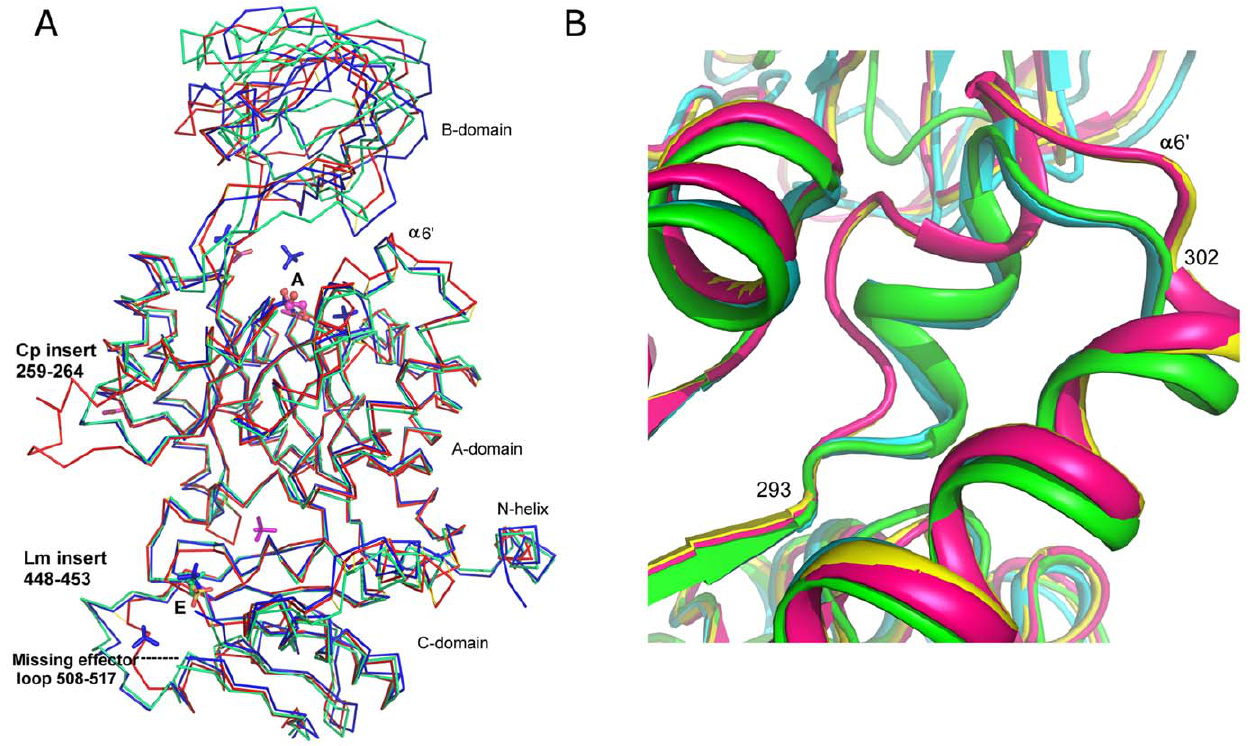
Figure 4. Comparison of CpPyK with LmPyK. (A) Superposition of A monomers of CpPyK (red), L. mexicana PyK without sulfate ion in the active site (1PKL, green), and L. mexicana PyK with sulfate ion in the active site (3E0V, blue). Sulfate ions bound at the effector binding site (labeled E) in all three structures are shown as stick models: CpPyK (yellow and red), 1PKL (green) and 3E0V (blue). Sulfate ions in the active site area (labeled A) in 3E0V are also shown in blue. One additional sulfate in the CpPyK structure at the interface of the C and A domains is shown in magenta. The glycerol molecule in the active site of CpPyK is shown as a ball and stick model. The two areas of the protein structures affected by the insertions in L. mexicana and C. parvum sequences are labeled. (B) Unwinding of helix a 6’ in both monomers of CpPyK (red and yellow) as compared to 3E0V (cyan) and 1PKL (green). Residues 293 and 302 for CpPyK are labeled.